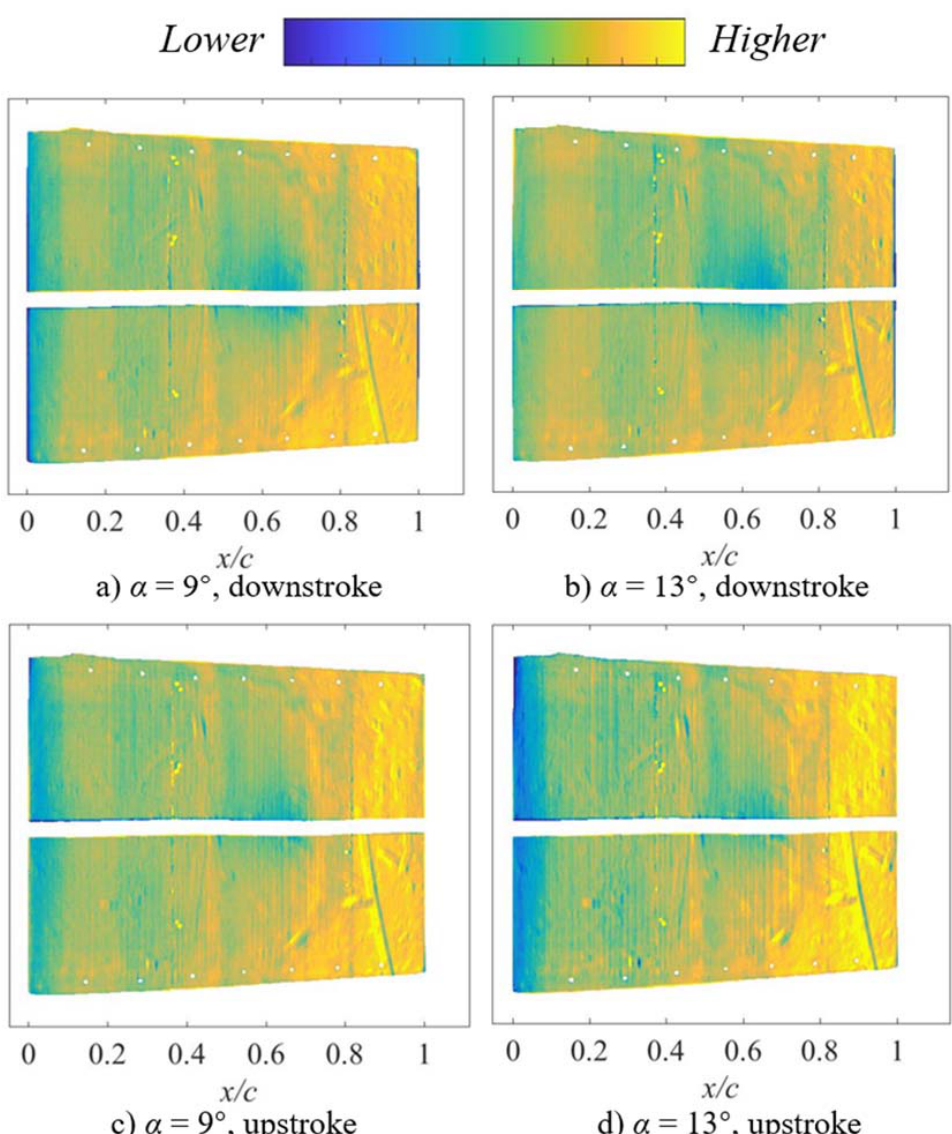
Figure 2. PSP visualization of the dynamic pressure on the oscillating airfoil with f = 1 Hz. (The horizontal direction is the full chord length, and the vertical direction is the spanwise direction).